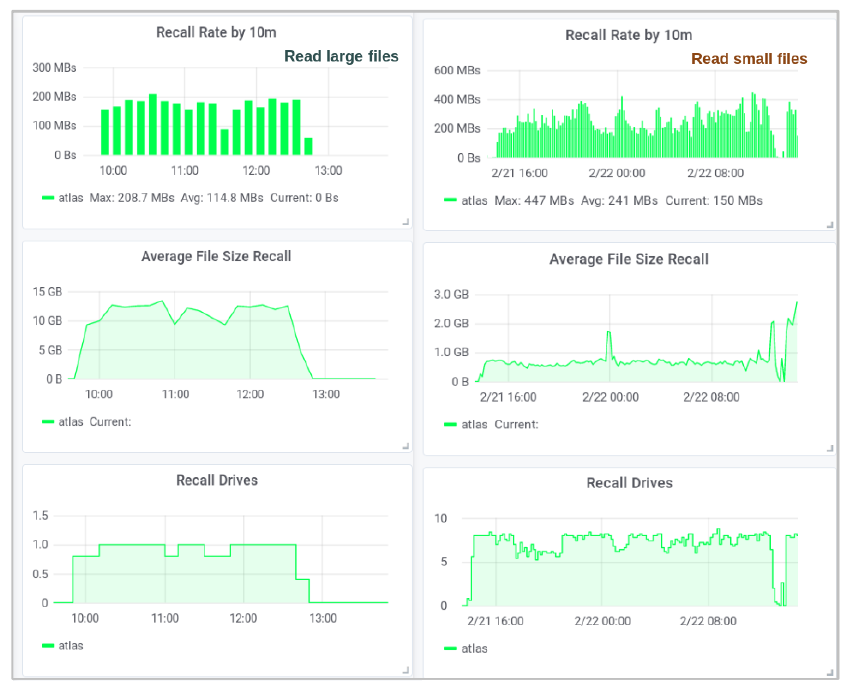
Figure 7: Reading small (less than 1.0GB file size) and large (larger than 9.0GB file size) files from